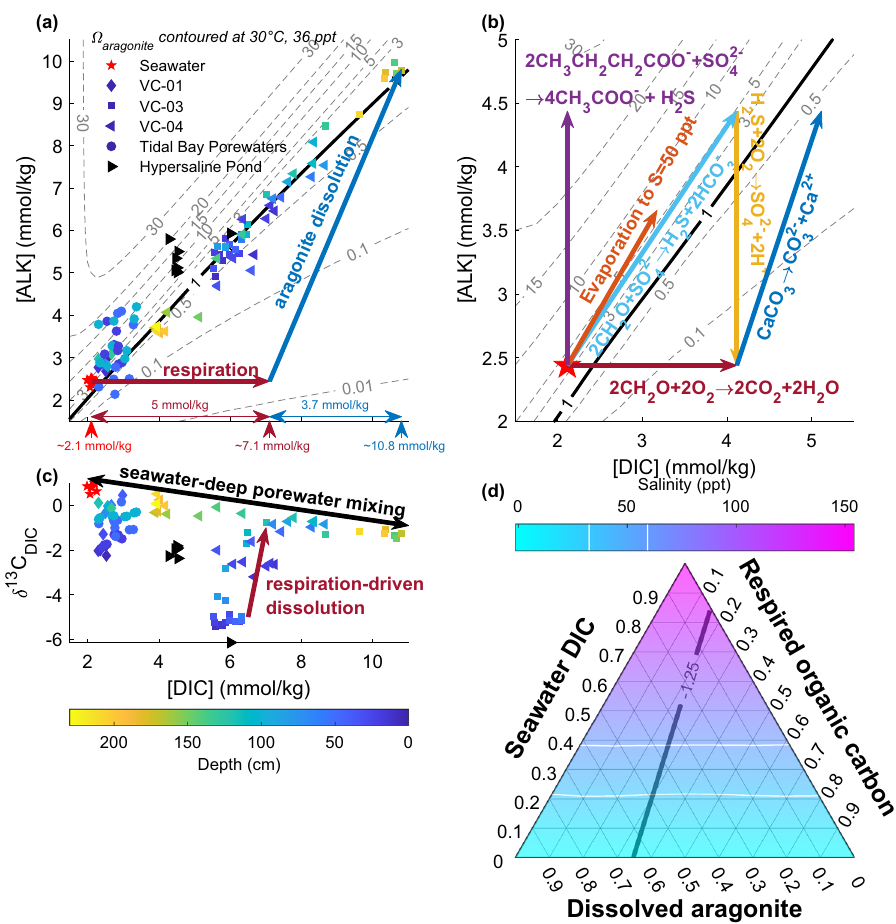
Fig. 5 Processes impacting porewater carbonate mineral saturation. Symbol shapes indicate sample location, symbol colors show depth, and arrows mark the effect of biogeochemical processes on DIC and alkalinity (ALK). a DIC and alkalinity data show that dissolution of ooid-skeletal sand contributed to increasing porewater carbon content and maintained aragonite saturation. If respiration-driven dissolution occurred by completely oxidizing organic matter, then the highest DIC, deep porewater must have ~5mmol/kg of respired carbon. b Geochemical reactions that may non-uniquely sum to produce the DIC and alkalinity relationship observed. Aerobic respiration (red) and sul fi de oxidation to sulfate (yellow) lower Ω , while aragonite dissolution (dark blue), anaerobic respiration by sulfate reduction (light blue), incomplete anaerobic respiration, and fermentation of organic matter to dissolved organic matter by sulfate reduction (purple), and evaporation (orange) increase Ω . c DIC concentration and DIC δ 13 C data show that core tops (shallower than ca. 100cm) are dominated by DIC from respired organic material and core bottoms contain increasing amounts of DIC from dissolved aragonite sand. d Ternary diagram of inorganic carbon sources in the highest DIC, deep porewater (10.8mmol/kg), which has a δ 13 C value of − 1.25 ‰ . It cannot have more than ~30% contribution from seawater DIC without exceeding observed salinities (white breaks in the color scale), so isotope mass balance indicates that it cannot have more than about 30% (~3mmol/kg) contribution from respired carbon. This discrepancy with the stoichiometry of respiration-driven dissolution in panel a implicates a leak of unoxidized organic matter such as from the production of dissolved organic matter by incomplete anaerobic respiration and enables net aragonite dissolution (Fig. 4). At low tide, sulfate reduction occurs beneath a thermally strati fi ed upper porewater lid, and saline, sul fi dic porewater with high Ω seeps from the shallow subsurface into tidal channels. At high tide, seawater seeps into the shallow subsurface, oxidizing sul fi de and driving aragonite undersaturation. Net dissolution of carbonate sedi-